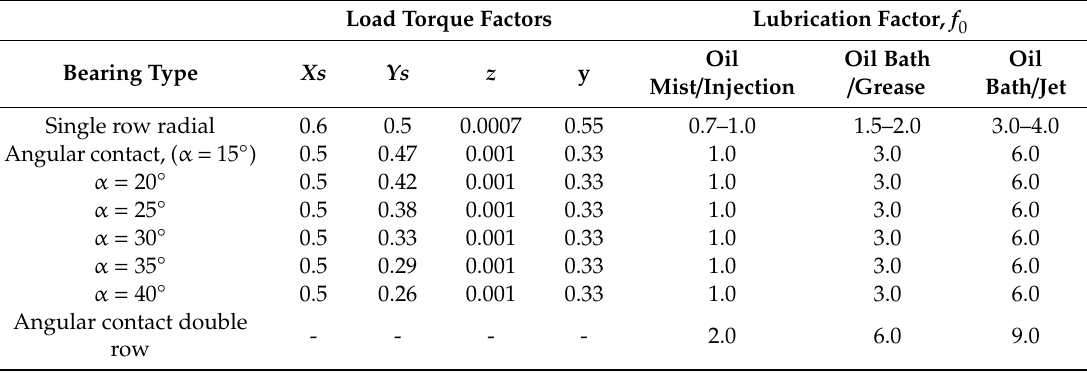
Table A2. Values of the load factor, torque factor and lubrication factor